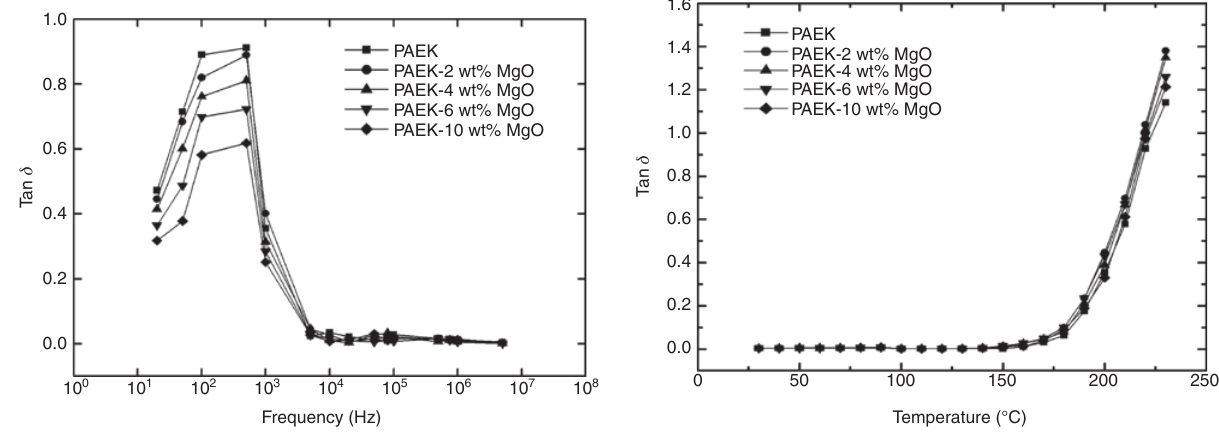
Figure 5: Effect of frequency on tan δ for PAEK-MgO nanocomposites.